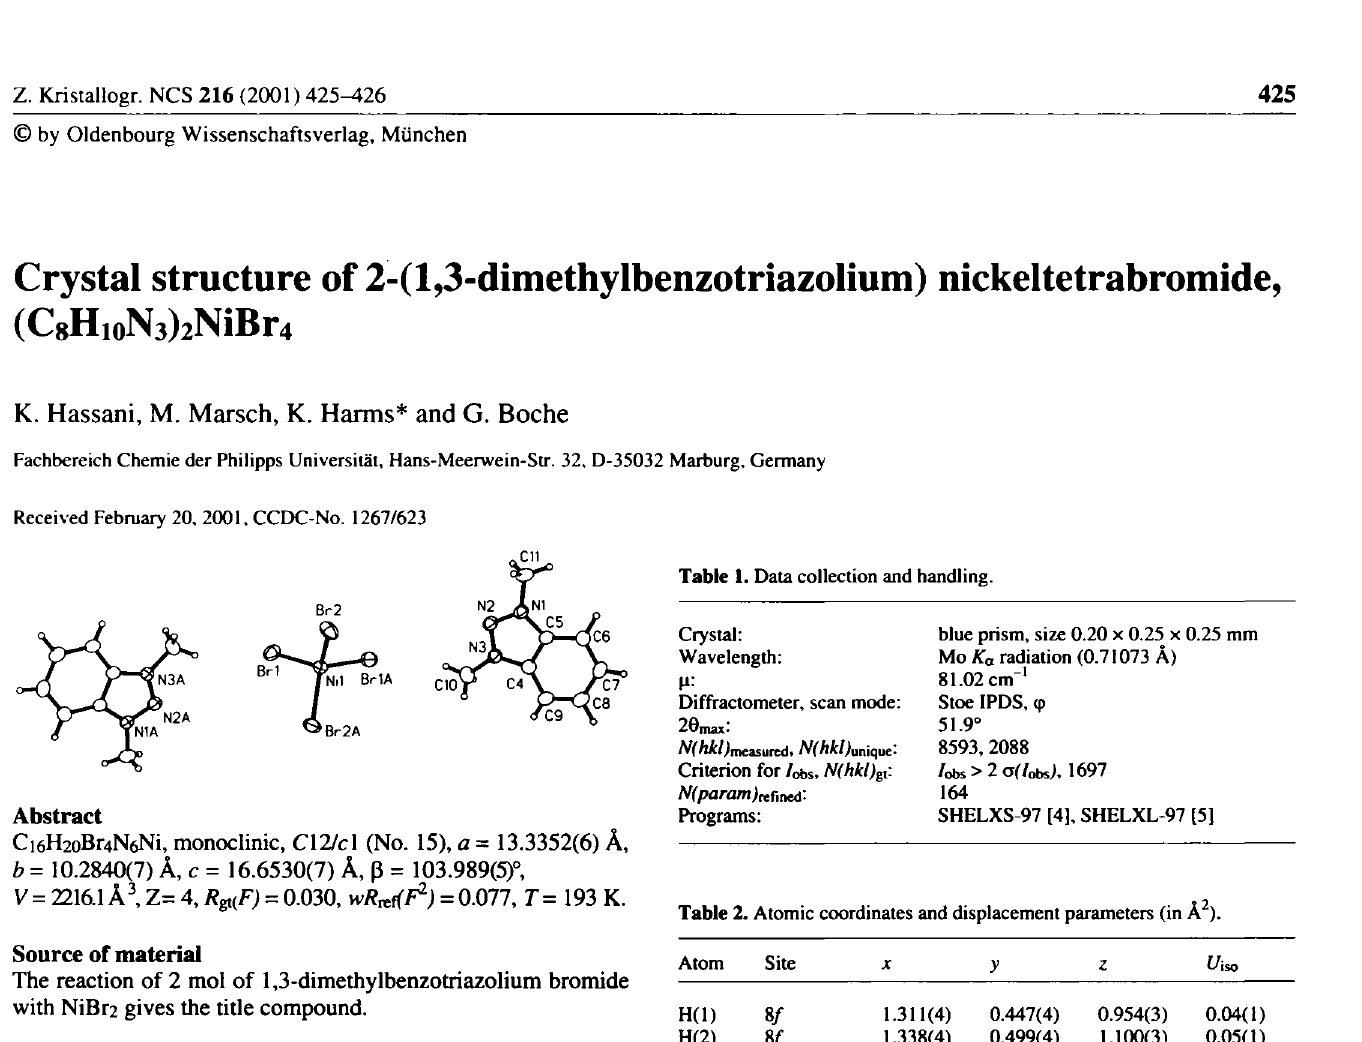
Table 2. Atomic coordinates and displacement parameters (in Ä 2 ).